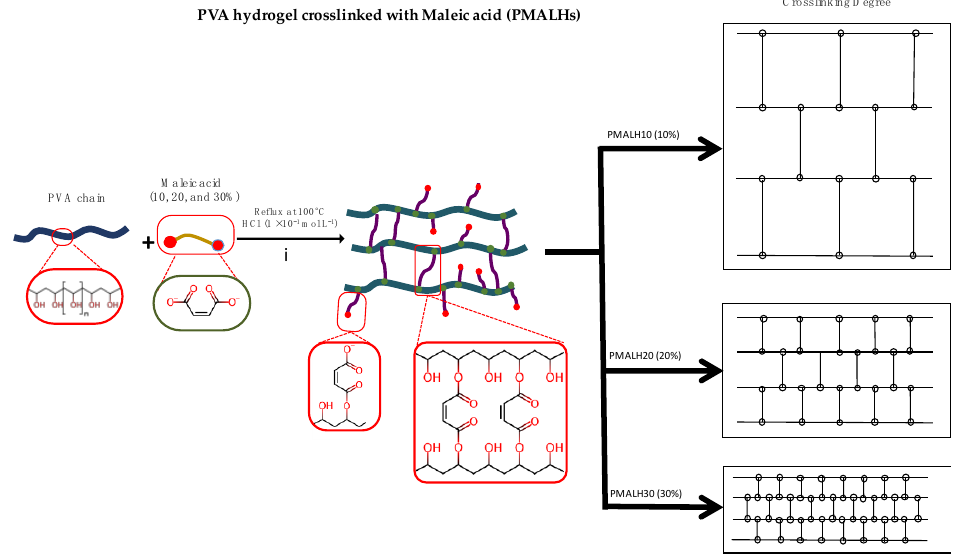
Figure 1. Scheme of synthesis of PMALH Hydrogels. Esterification reaction of PVA with MAL at three different ratios.